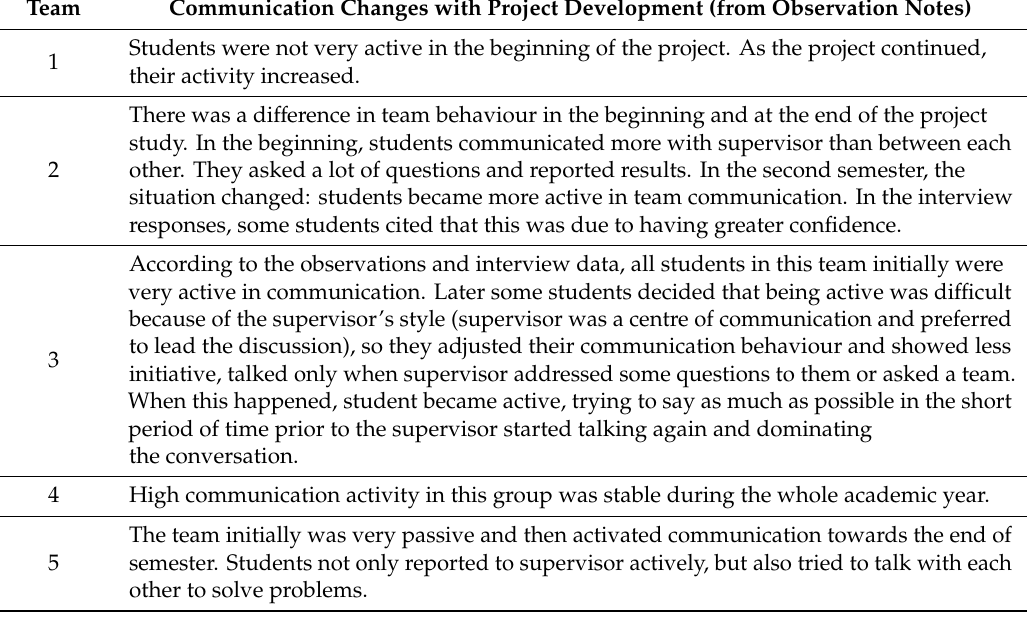
Table3. Communicationactivitychangesforstudentsduringthedi ff erentstagesofprojectdevelopment. Team